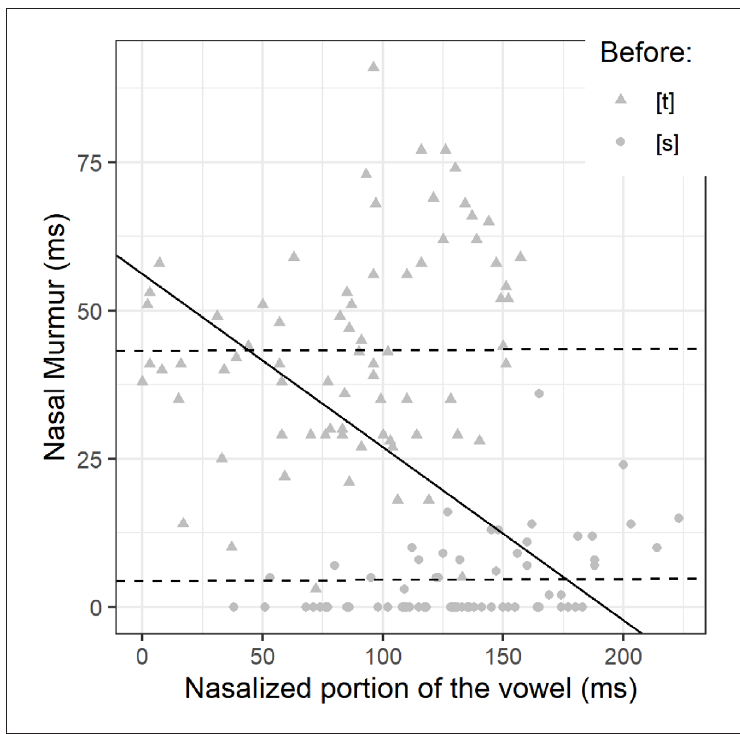
Figure 6: Mean duration (ms) of the nasal murmur as a function of the mean duration (ms) of the nasalized portion of the vowel for both consonant contexts (solid line) and by consonant (dashed